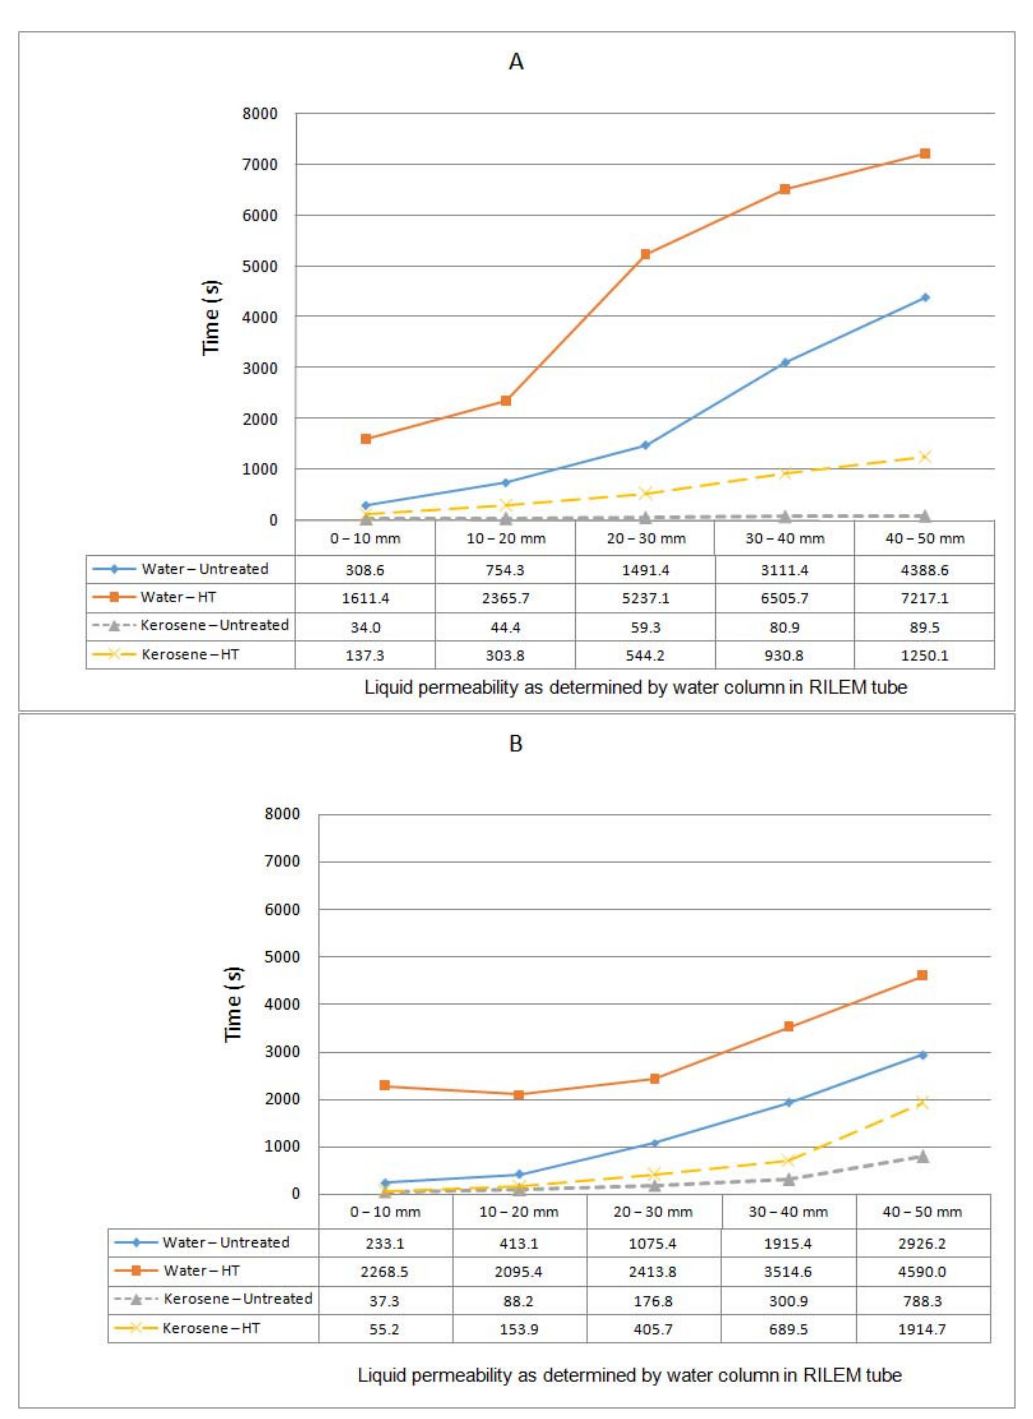
Figure 4. Liquid permeability, as determined by the time it took for the water column to drop in the RILEM tube, in Populus nigra var. betulifolia with 3 × 4 m spacing ( A ) and 3 × 8 m spacing ( B ) (HT = heat-treated).